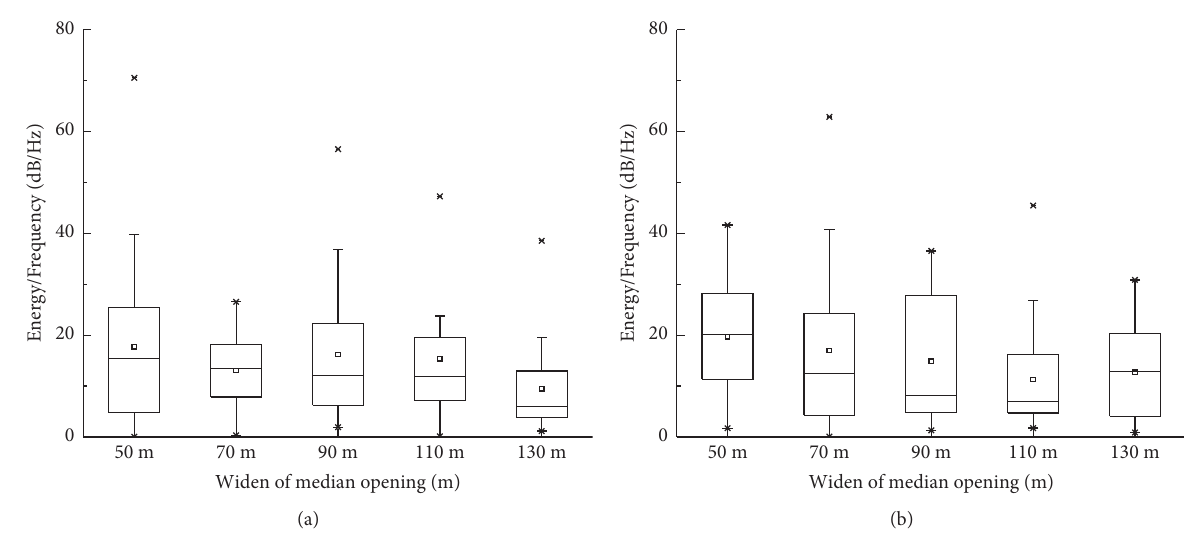
Figure 9: Driving workload box diagram of different simulation configurations: (a) entrance by-pass; (b) exit